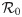
Door-to-door only control costs, application frequencies, and application periods required to bring R0 to unity (or as low as possible when the system is uncontrollable) as a function of percent compliance.Blue, red, and green curves correspond to the hopping rates ω = 5μ0, ω = μ0, and ω = 0.5μ0, respectively. For each value of percent compliance and hopping rate, we average over 200 random neighborhood compliance configurations that are either highly clustered (dashed curves) or randomly dispersed (solid curves), assuming periodic boundary conditions. The crossover points in the zoomed-in plot in Fig. 8b indicate cut-off compliance levels beyond which door-to-door only control becomes more cost-effective than aerial only control on average. Figures 8c and 8d represent the same information; we display both application period and application frequency for visual clarity.